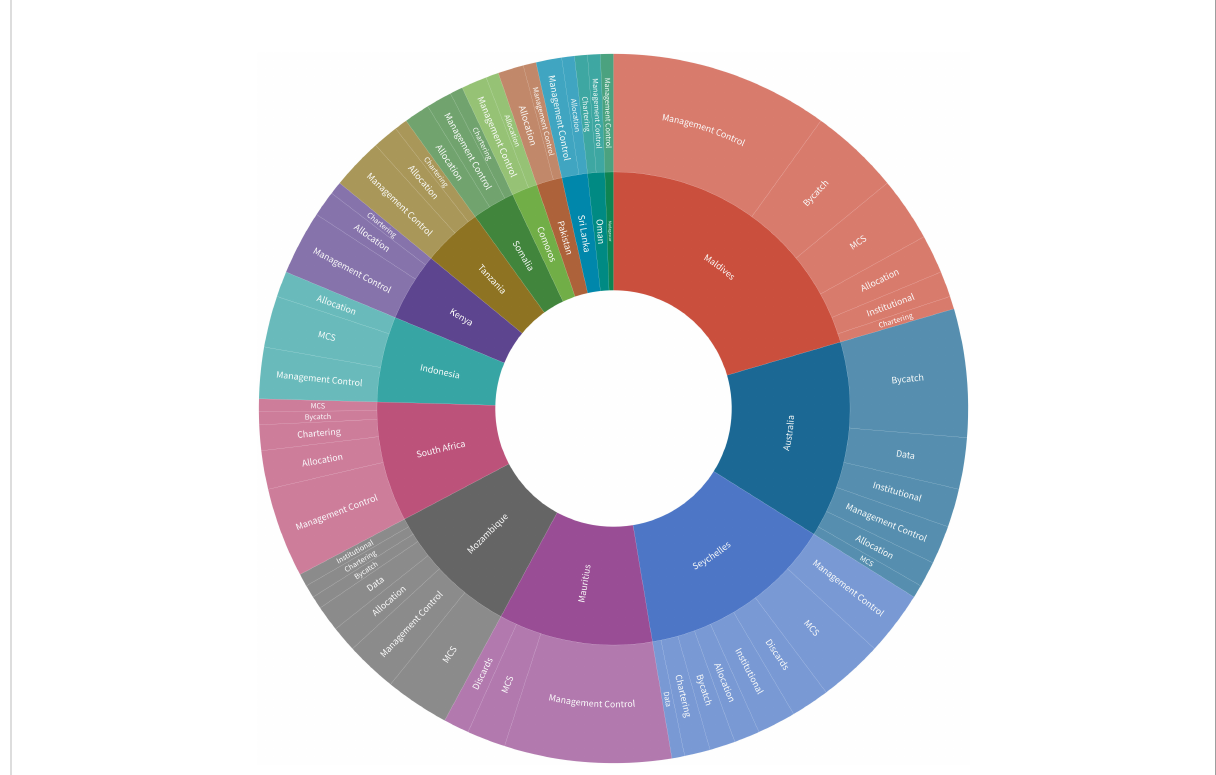
FIGURE 2 Category of proposals submitted by G16 Member States from 2012 – 2021. The width of the pie represents the number of the proposals submitted by each Member